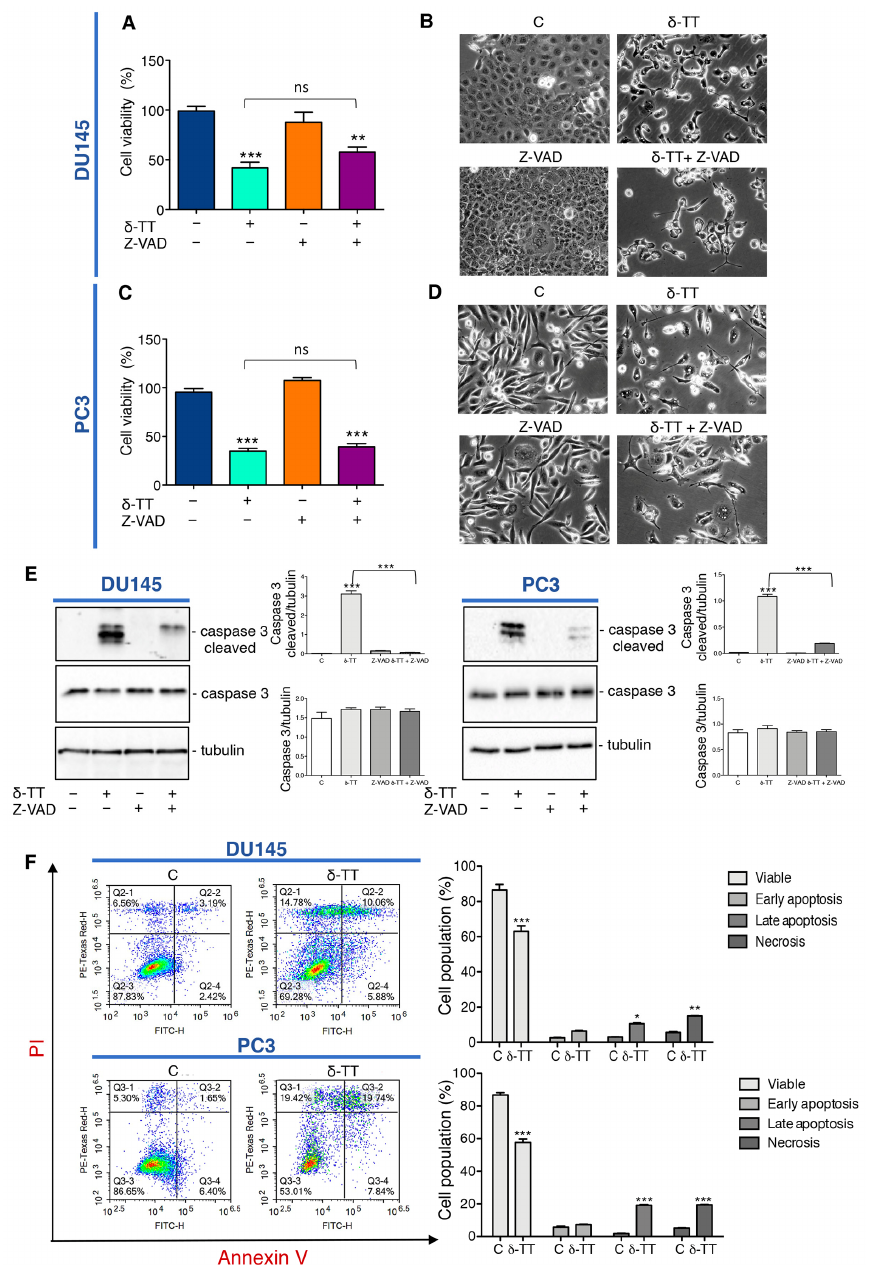
Figure 1. δ -Tocotrienol ( δ -TT) induces cell death in prostate cancer cells. ( A ) Cell viability analysis after δ -TT treatment (20 μ g/mL, 24 h) in combination with or without pan-caspase inhibitor carbobenzoxy-valyl-alanyl-aspartyl-[O-methyl]- fluoromethylketone (Z-VAD) pretreatment (50 μ M, 4 h) was determined by MTT (3-(4,5)-dimethylthiazol-2-yl-2,5-diphenyltetrazolium bromide) assay in DU145 cells. Six independent biological samples for each condition were analyzed ( n = 6); bar graph represents the mean relative cell viability ± SD. Statistical analysis was performed using one-way ANOVA followed by Bonferroni post-hoc test (** = p < 0.01 vs. C; *** p < 0.001 vs. C). ( B ) Morphological analysis of DU145 cells after δ -TT treatment (20 μ g/mL, 24 h) in combination with or without Z-VAD pretreatment (50 μ M, 4 h) was analyzed by phase-contrast microscopy. ( C ) Cell viability analysis after δ -TT treatment (20 μ g/mL, 24 h) in combination with or without pan-caspase inhibitor Z-VAD pretreatment (50 μ M, 4 h) was determined by MTT assay in PC3 cells. Six independent biological samples for each condition were analyzed ( n = 6); bar graph represents the